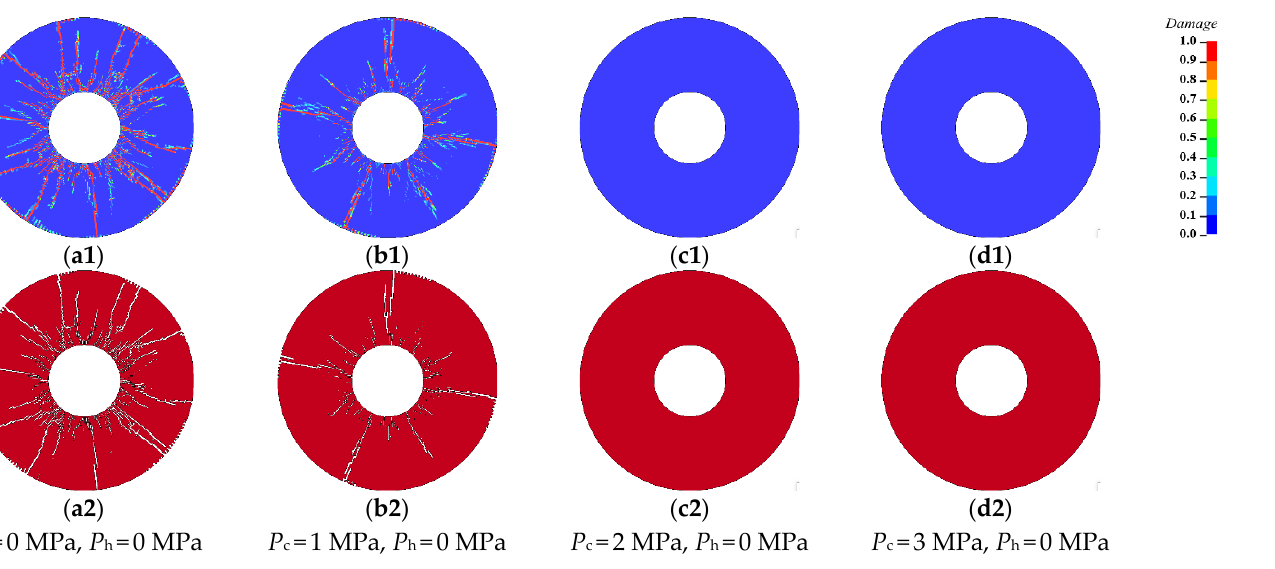
Figure 13. Case 2: ( a1 , b1 , c1 , d1 ) damage distribution in rock; ( a2 , b2 , c2 , d2 ) crack pattern.